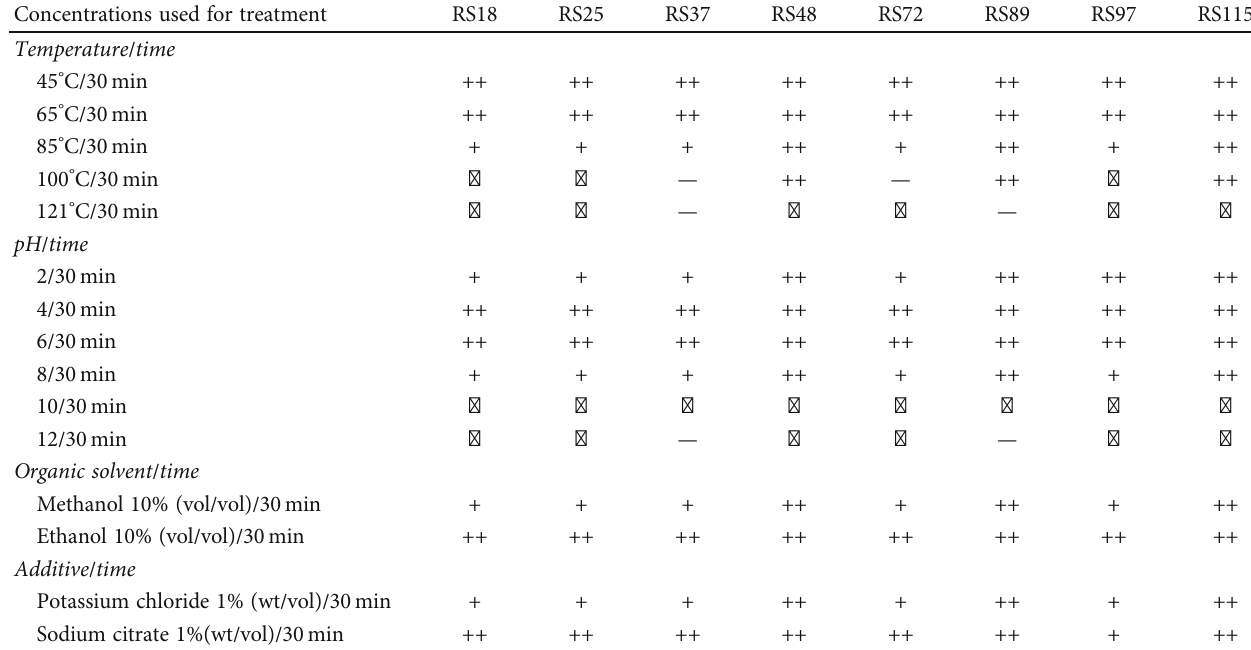
Table 6: The antagonistic e ff ects of temperature, pH, organic solvents, and additives on the CFS. Concentrations used for